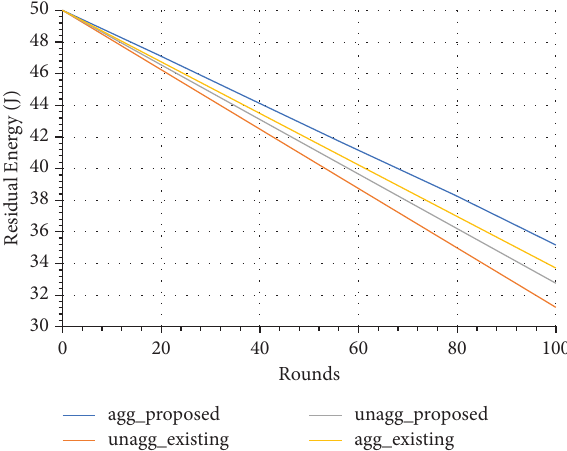
Figure 4: Comparative Analysis of residual energy.